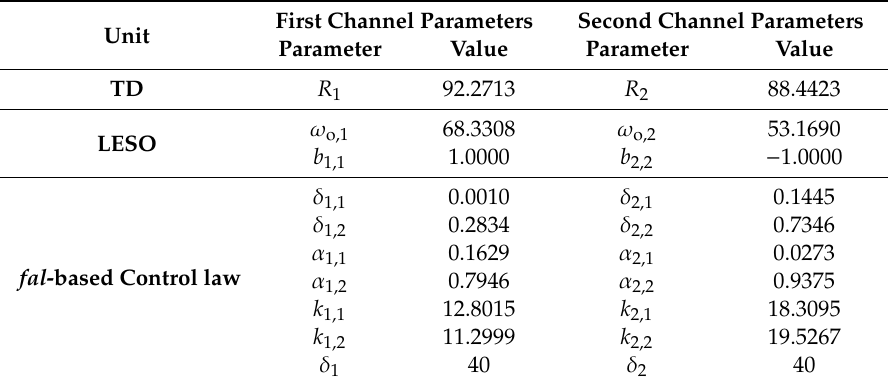
Table 4. The parameters of the first configuration (CADRC).